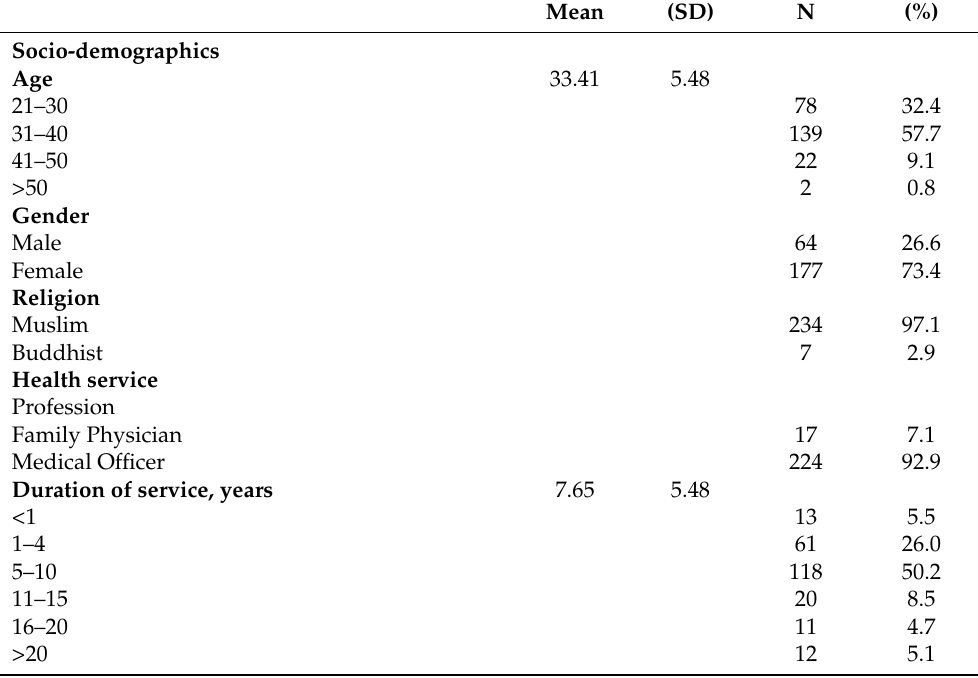
Table 1. Socio-demographics, health service characteristics, and exposure to palliative